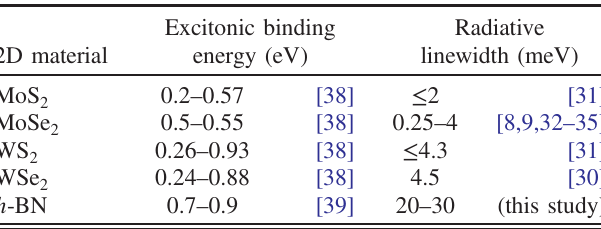
TABLE II. Excitonic binding energy and radiative linewidth for various 2D